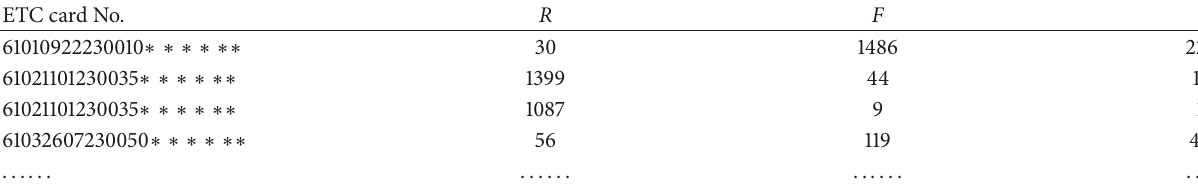
Table 3: Extraction results of ETC customer segmentation index.